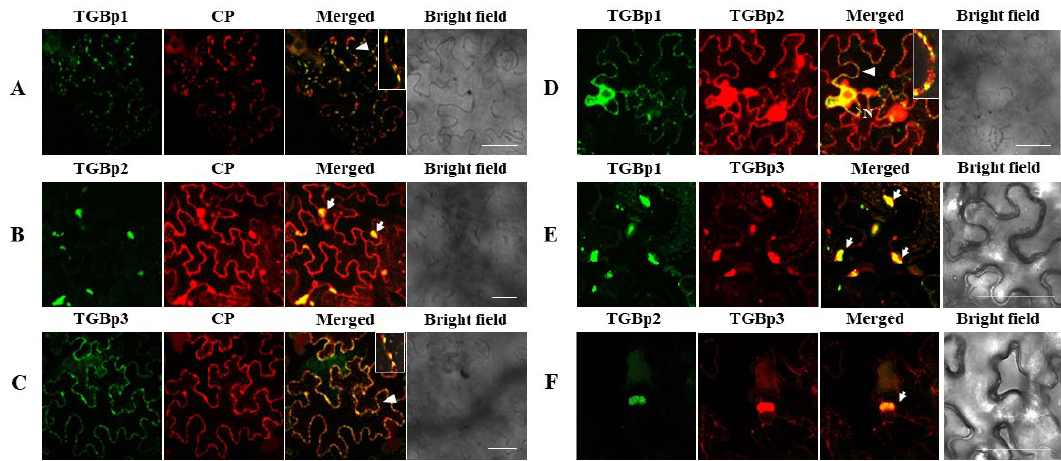
Figure 6. Subcellular colocalization analyses of CYVCV proteins fused with CFPs (green fluorescence) and YFPs (red fluorescence) by transient expression in N. benthamiana leaves and visualization under confocal microscopy. ( A – C ) Colocalization of CYVCV CP with TGBp1, TGBp2, and TGBp3 at the PD, granular masses and PD, respectively. ( D – F ) Colocalization of CYVCV paired proteins TGBp1 / TGBp2, TGBp1 / TGBp3 and TGBp2 / TGBp3. White arrows indicate colocalization as aggregates. The PD colocalization (white arrowheads), is highlighted in the boxes at the right upper corner of the corresponding figure panels. Photos were taken at 72 hpi. Scale bar = 25 µm.